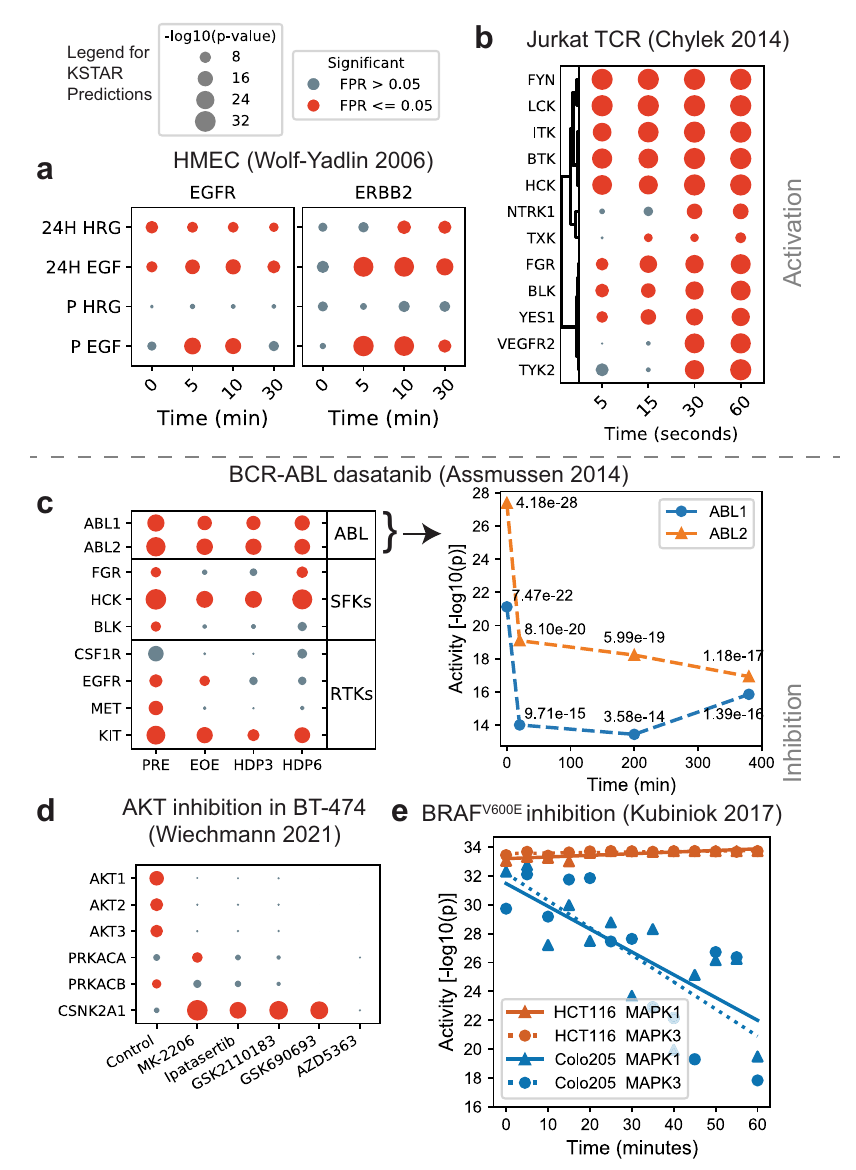
Fig. 2 | KSTAR applied to diverse cell models of kinase activation and inhibi- tion. Full KSTAR results for data in this fi gure available in Supplementary Note 3). Panel titles give the reference for the publication study of the phosphoproteomic data. All KSTAR predictions use the same legend for score size and signi fi cance as given above panel A. a Predicted activation patterns of HMEC cell lines (P for parental 184A1 and 24H for HER2 overexpressing 184A1) in response to EGF and HRG stimulation. b Predicted activation patterns of TCR stimulation in Jurkat cells showsearlyandrobustactivationofTCR-speci fi ckinases(this fi gureisinseconds). c Predicted kinase patterns in response to inhibition of BCR-ABL inhibition by dasatinib in K562 cells with a detailed plot of signi fi cance changes for the ABL